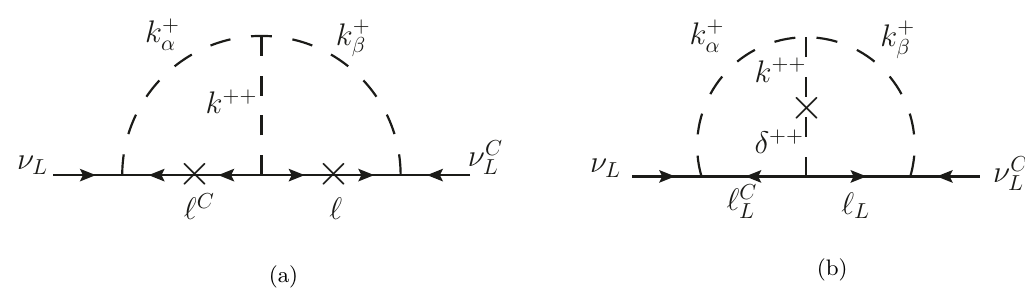
Figure 6 . Two-loop graphs responsible for neutrino mass